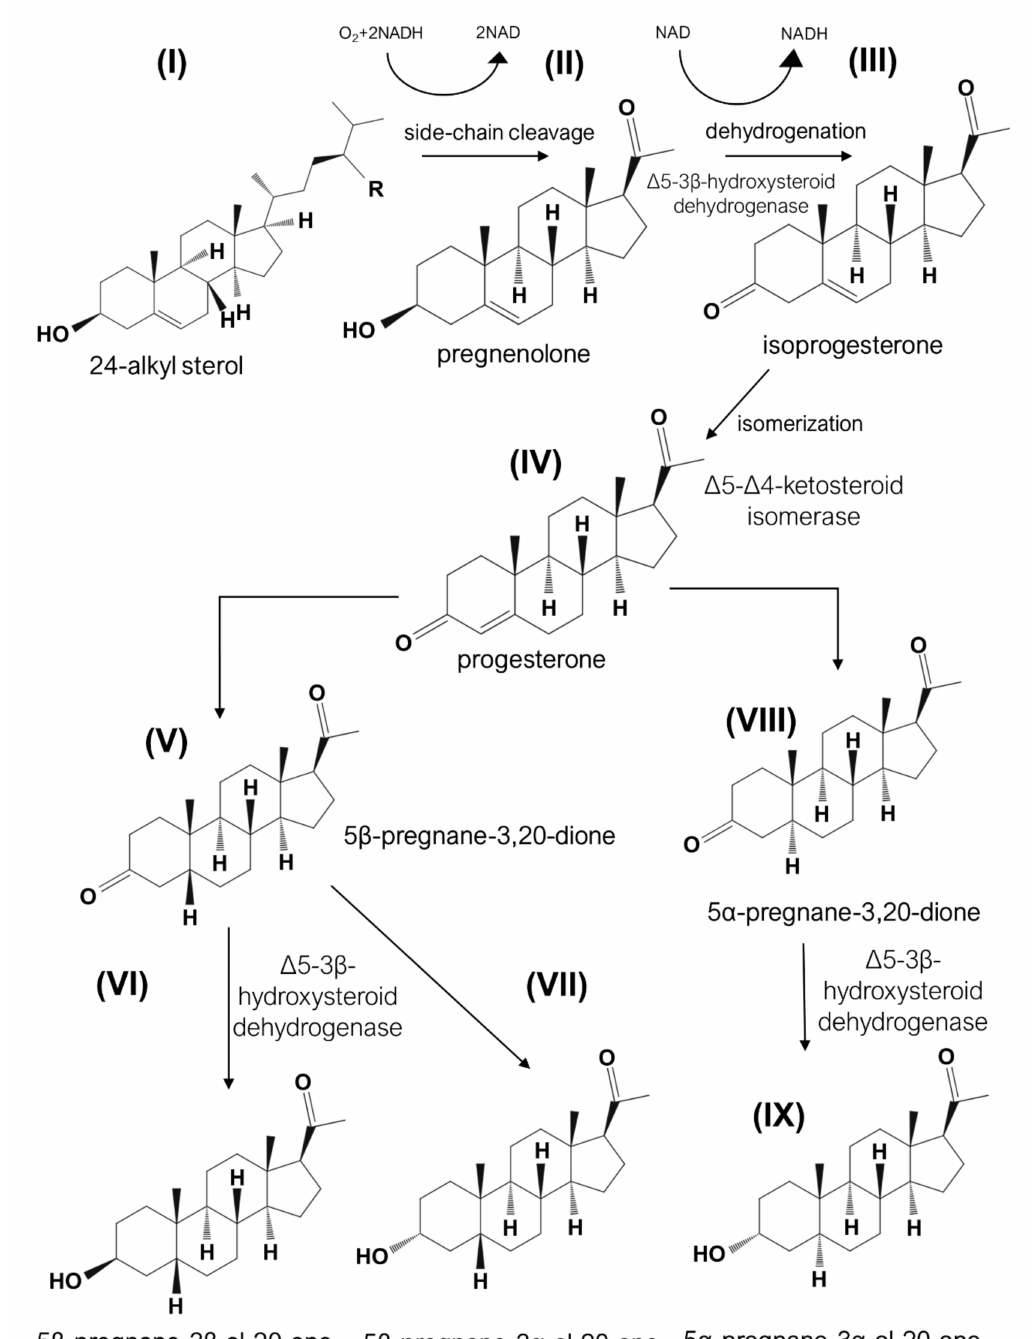
Figure 3. The proposed scheme of biosynthesis of progesterone and pregnenolone in plants. It is assumed that the synthesis starts from the cleavage of 24-alkyl sterols (I) side-chain resulting in the production of pregnenolone (II) following dehydro- genation in the presence of ∆ 5-3 β -hydroxysteroid dehydrogenase (EC 1.1.1.145) activity. The resulting isoprogesterone (III) is further isomerized by ∆ 5- ∆ 4-ketosteroid isomerase (EC 5.3.3.1) to progesterone (IV). Further transformation to products (V)-(IX) is accomplished in the presence of ∆ 5-3 β -hydroxysteroid dehydrogenase (EC 1.1.1.145) activity that, eventually, catalyzes the production of glycosides. It is assumed that progesterone and pregnenolone are essential intermediated in plant biosynthesis of glycosides. Both enzymes are ubiquitously distributed among plants and microorganisms, whereas in animals, these two enzymes reside in one-single protein. The ∆ 5-3 β -hydroxysteroid dehydrogenase has a higher preference for NAD instead of NADPH, which is also accepted by lower